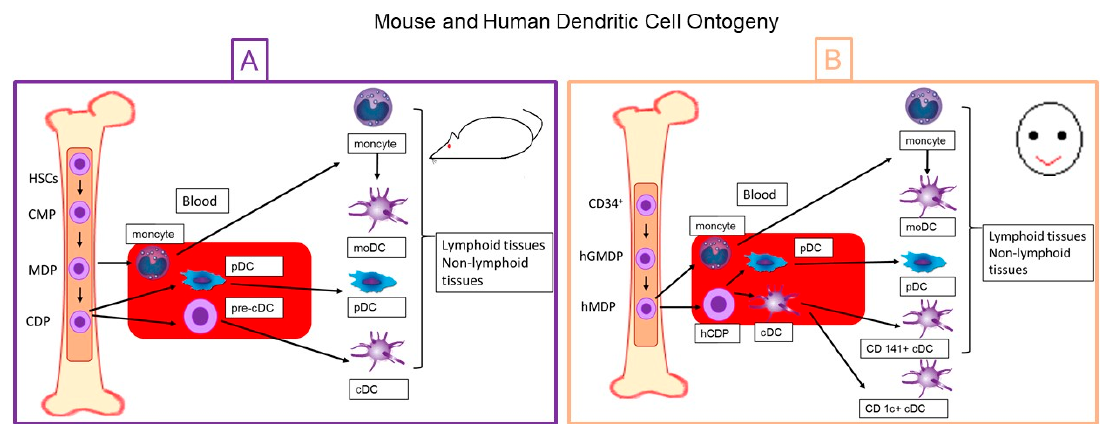
Figure 1. Mouse and human dendritic cell ontogeny. Schematic representation of ( A ) mouse and ( B ) human dendritic cell ontogeny. DC: dendritic cell; HSCs: hematopoietic stem cells; CMP: common myeloid progenitors; MDP: monocyte and dendritic cell progenitor; CDP: common dendritic cell progenitor; pDC: plasmacytoid DCs; pre-cDC: precursors of conventional DCs; moDC: monocyte- derived DC; pDC: plasmacytoid DC; cDC: conventional DC; hGMDP: human granulocyte-monocyte-